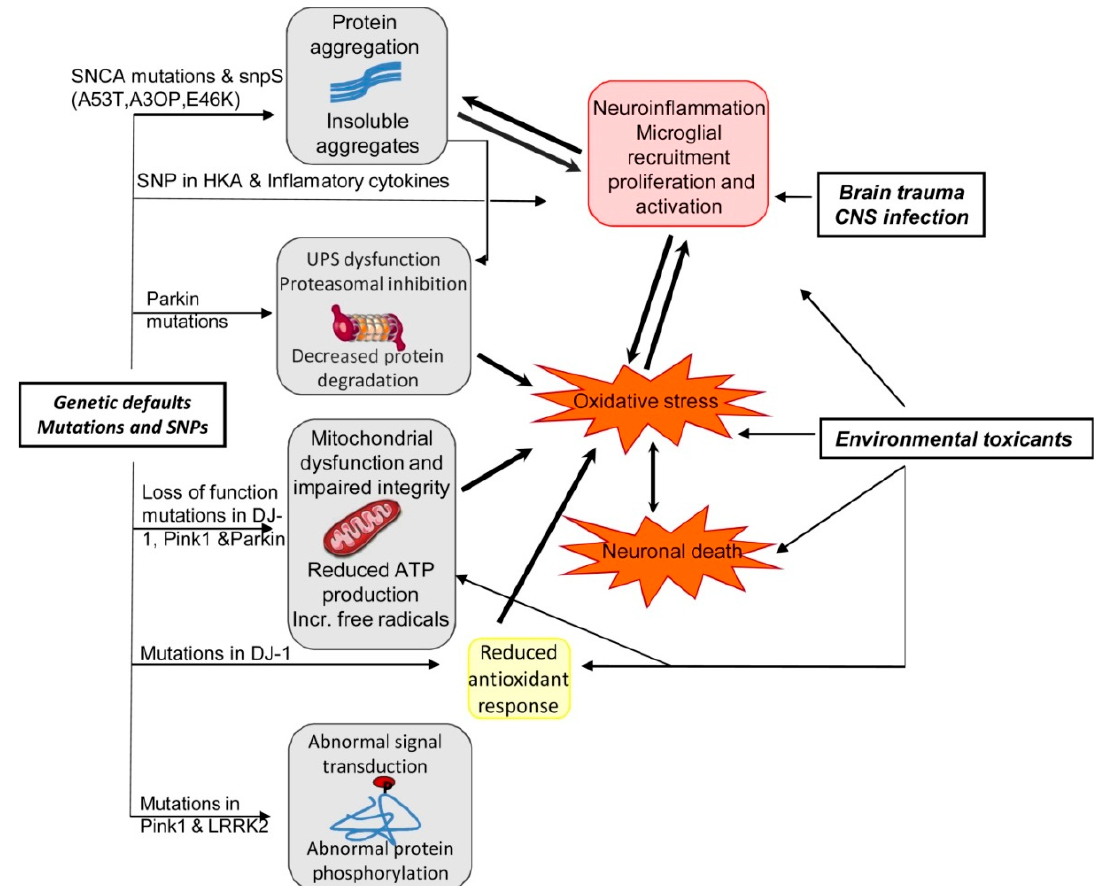
Figure 5. Summary of the effects of interaction between genetics and environmental factors in PD patho-genesis [92]. Abbreviations: ATP, adenosine triphosphate; CNS, central nervous system; LRRK2, leucine-rich repeat kinase 2; Pink1, PTEN (phosphatase and tensin homologue)-induced kinase1; SNCA, alpha synuclein; SNP, single-nucleotide polymorphism; UPS, ubiquitin proteasome system. Figure reproduced with permission from Ref [92]. Copyright 2014, Elsevier.